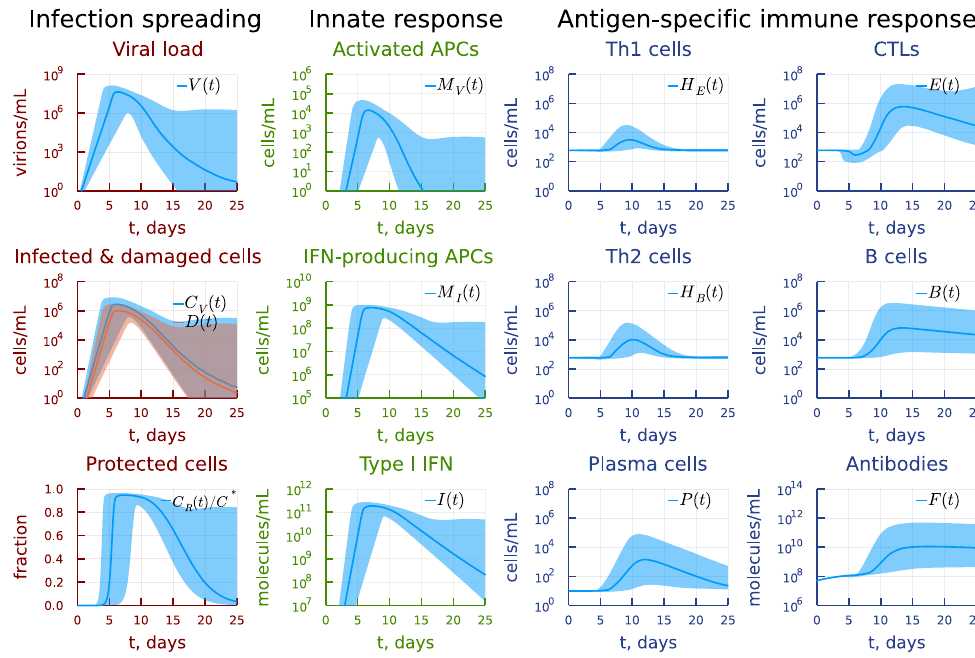
Figure 5. Mild-to-moderate disease severity phenotype. Variability of the model solution due to 20% variation of the parameter values around their basal values specified in Table 1 is presented as medians and 90% confidence bands based on 0.05 and 0.95